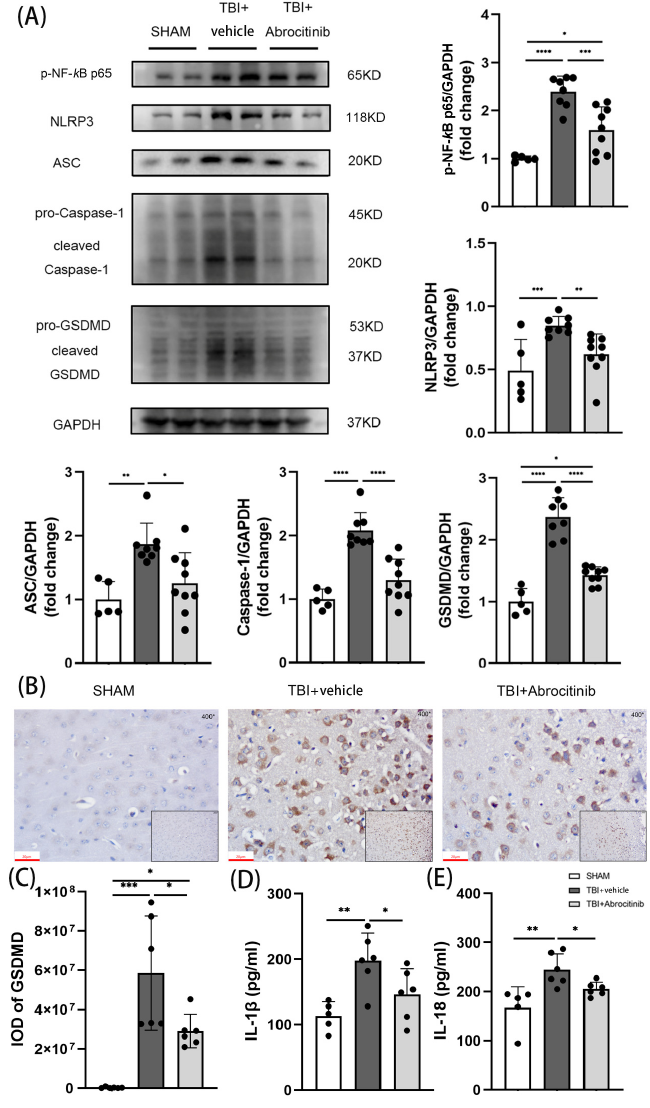
Figure 6. Effects of abrocitinib on NF κ B-related inflammation and pyroptosis pathways. On the 1st day after TBI, NF κ B-related inflammation and the activation of pyroptosis pathways were dra- matically increased. After abrocitinib treatment, the indicators of NF κ B-related inflammation and pyroptosis pathways were significantly decreased, as can be seen from the WB (n = 5–9 one-way ANOVA with Tukey’s post-hoc test) and GSDMD IHC staining ( A – C ) (n = 6 Kruskal-Wallis test). From the ELISA results, the changes in inflammatory cytokines (IL-1 β and IL-18) after brain injury and the effects of abrocitinib were precisely revealed ( D , E ) (n = 5–6 one-way ANOVA with Tukey’s post-hoc test). All data are shown as mean ± SD. * p < 0.05, ** p < 0.01, *** p < 0.001, **** p <